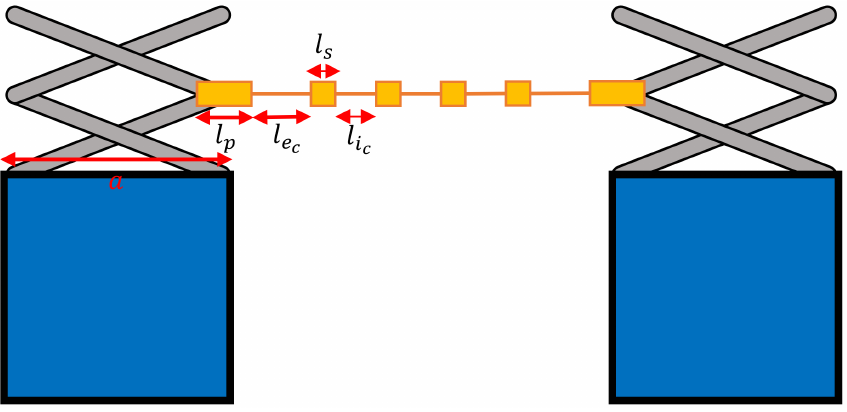
Figure 12. Geometry of the closed scissor-hinge